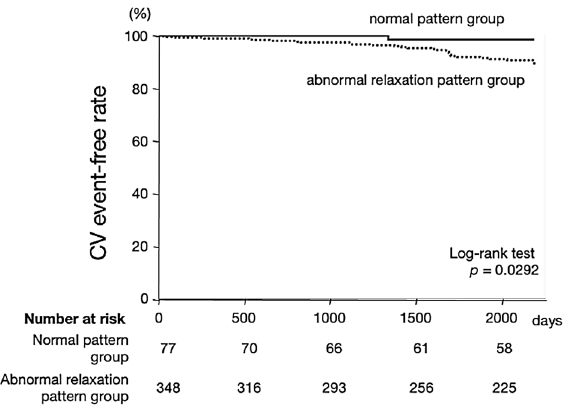
Figure 3. Kaplan–Meier survival analysis of cardiovascular (CV) event-free rates. The CV event-free rates were significantly decreased in the normal inflow group compared to the abnormal relaxation group ( p =